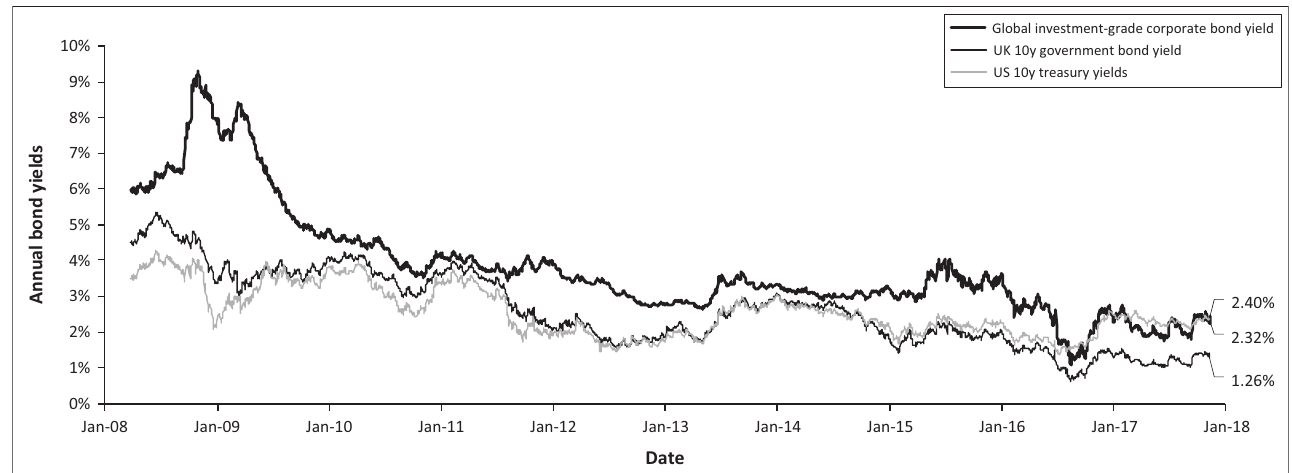
FIGURE 7: Developed economy bond yields since 2008.